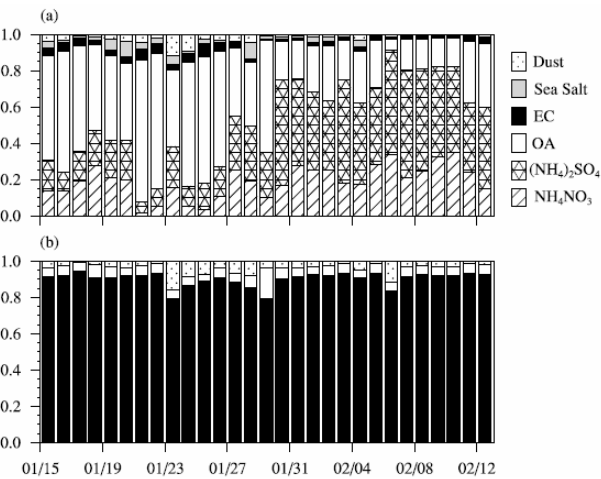
Fig. 8. Time series of fractional contribution of major aerosol com- ponents (i.e., dust, sea salt, elemental carbon (EC), organic aerosol Fig. 8. Time-series of fractional contribution of major aerosol components (i.e, dust, sea salt, (OA), (NH 4 ) 2 SO 4 and NH 4 NO 3 ) to (a) the aerosol scattering coef- elemental carbon (EC), organic aerosol (OA), (NH 4 ) 2 SO 4 and NH 4 NO 3 ) to (a) the aerosol scattering ficient and (b) the aerosol absorption coefficient, respectively. coefficient and (b) the aerosol absorption coefficient, respectively.